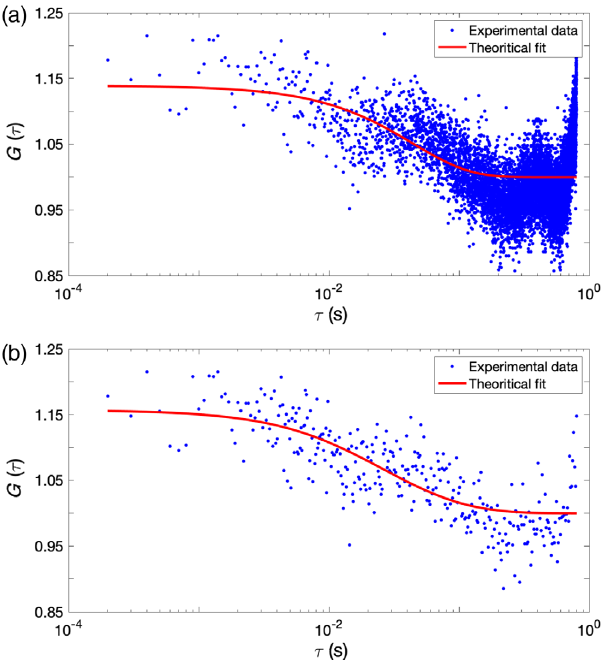
FIG. 14. FCS curves resulting from exceedingly short traces (same synthetic data as Fig. 1) with linear (a) and semilogarithmic (b) binning. Because of the limited data, the quality of the fitted autocorrelation curve G ð τ Þ does not improve considerably for (b) as compared with